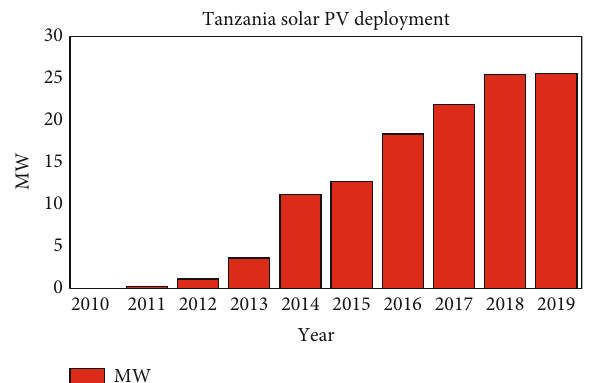
Figure 23: Minigrid locations and numbers in Tanzania.